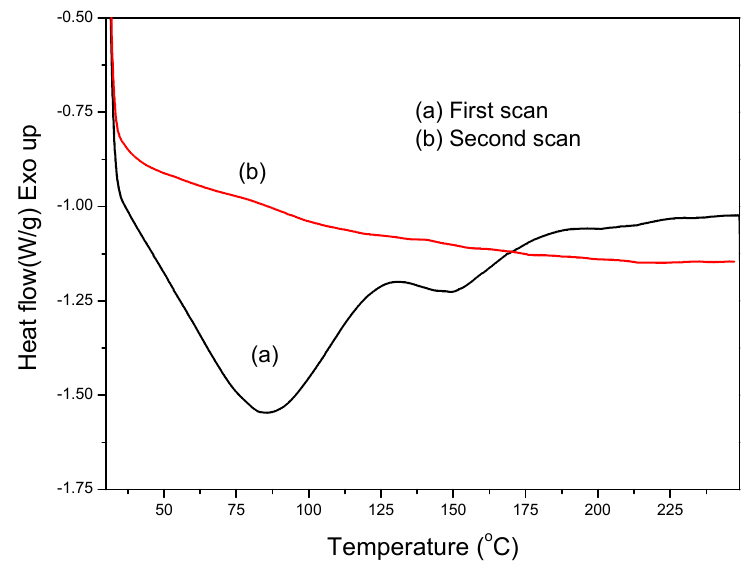
Figure 1. Typical differential scanning calorimetry (DSC) thermograms for dynamic scanning of sulfonated poly(ether ketone/ether benzimidazole) (SPEKEBI) with KH-560.